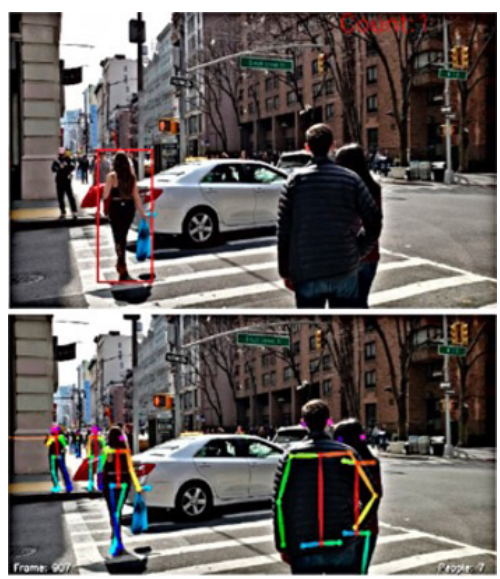
Fig. 6 Use of edge computing in Ref. [53] to detect a pedestrian crossing during a red-light (top) and analyze body language (bottom). Images courtesy of Potdar and Torrens, used with